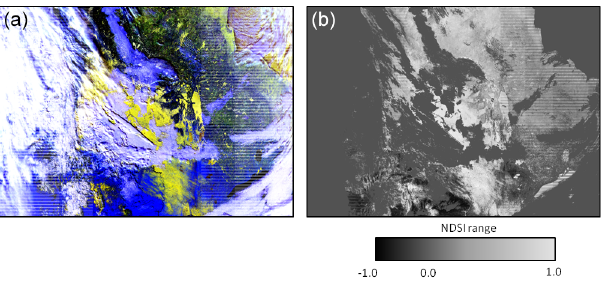
Figure 3. VIIRS NDSI. VIIRS swath of NDSI dataset (b) for 5 De- cember 2014 19:45UTC compared to false color display of bands I1, I2 and I3 (a) with snow-covered landscape in hues of yellow. NDSI data in the range of − 1.0 to 1.0; clouds, oceans and night are masked. Swath covers central Canada; Lake Winnipeg is near the center of the swath and the Plains of the USA. Note that the striping at the edge of the VIIRS swath is the result of “pixel trimming”, resulting in a reduction in the VIIRS “bow-tie” effect in the NASA Level 1 product (Wolfe et al., 2013).